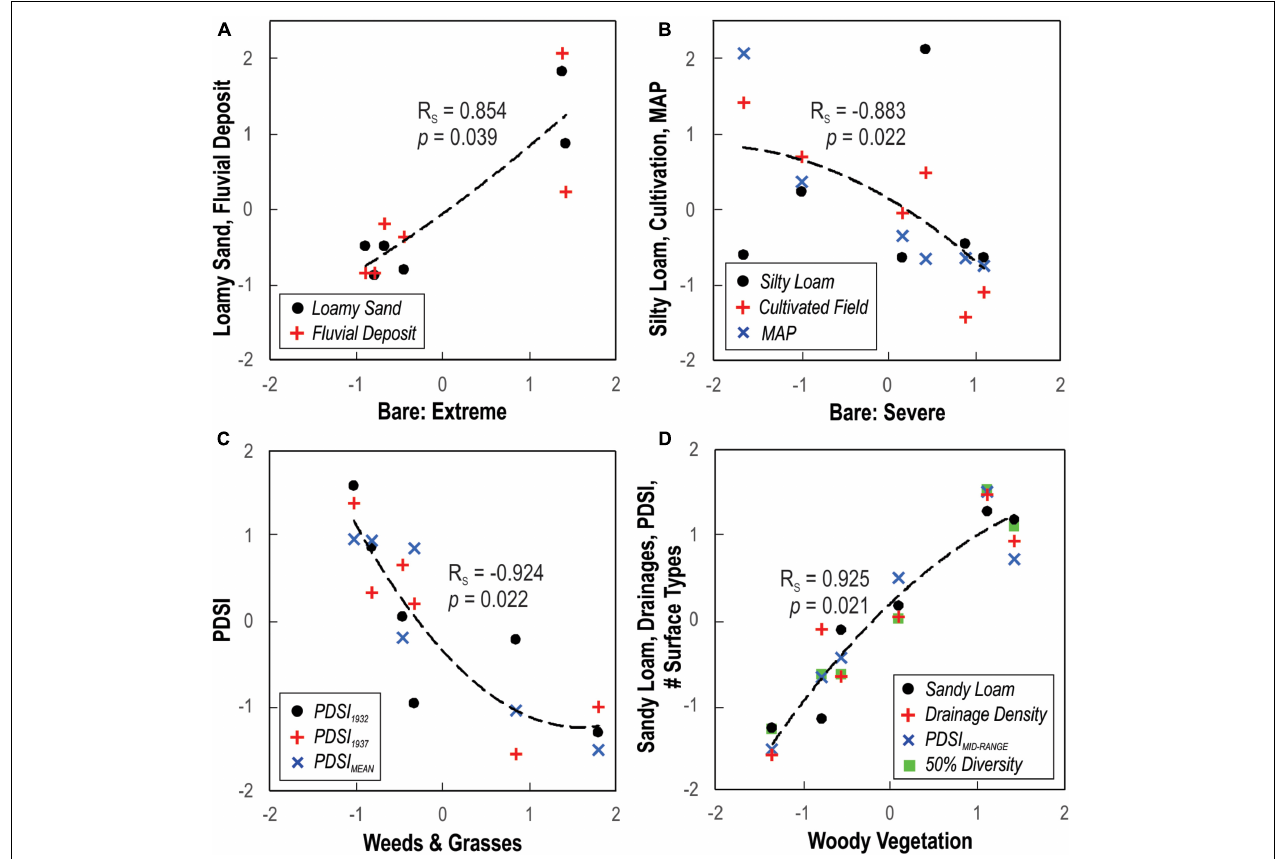
FIGURE 8 | Scatter plots of selected variable pairs receiving a Spearman’s rank correlation coefficient ( R S ) equal to or over ± 0.8 and where p ≤ 0.05 exhibit monotonic relationships between land cover, sediment texture, land use, and/or climatic factors: (A) area of extremely bare surfaces increases with area of loamy sand soils and fluvial deposits; (B) extent of severely bare surfaces increases where areas of silty loam soils and mapped cultivated fields decrease, and where mean annual precipitation (MAP) is lower; (C) cover of patchy weeds and grasses increases in counties where the Palmer Drought Severity Index (PDSI) is lower in 1932, 1937, and in the overall mean from 1931 to 1940; and (D) the densest, woody vegetation increases in coverage with areas of sandy loam soils, greater density of fluvial drainages, a higher mid-range PDSI from 1931 to 1940, and the number of surface types explaining at least half of the total surface area (50%